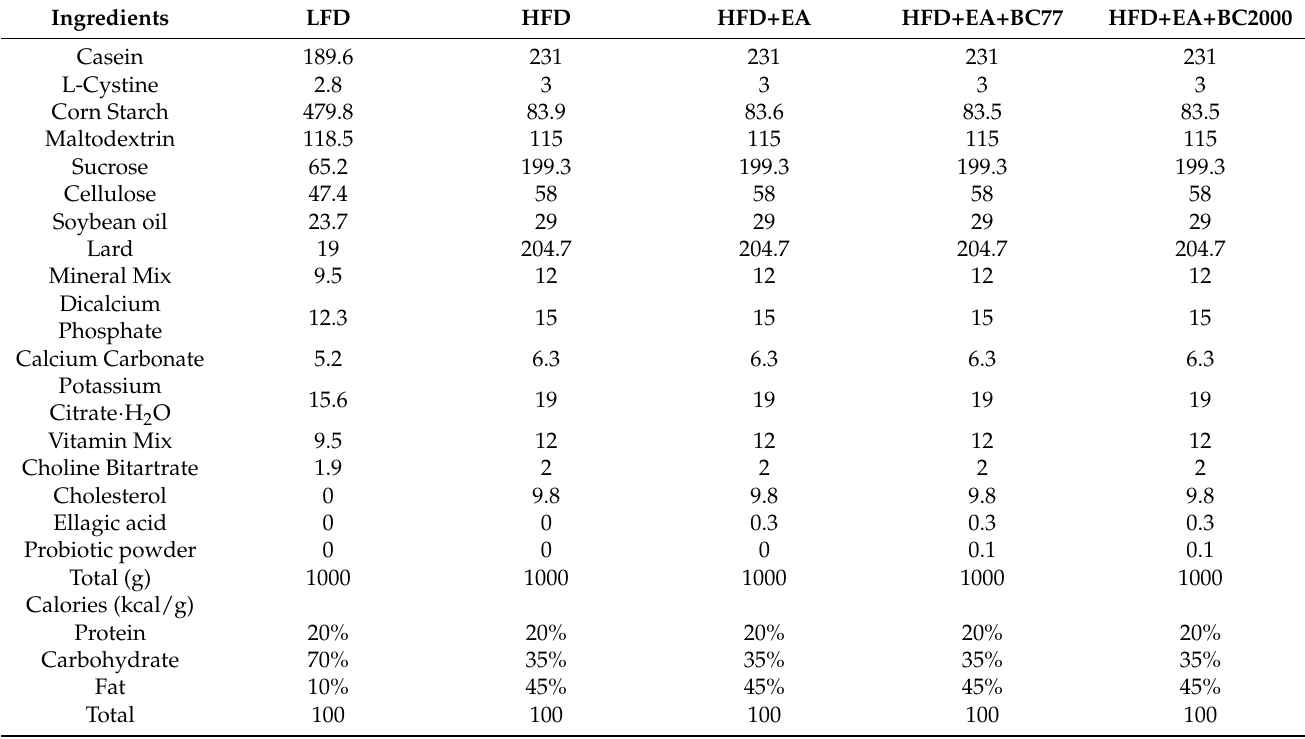
Table 1. Composition of animal feed